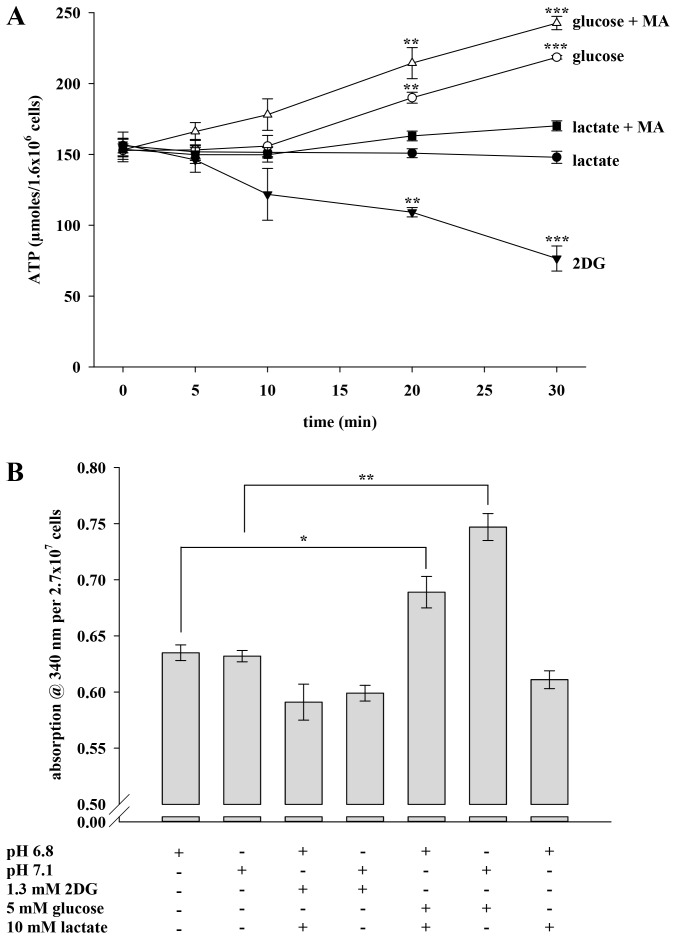
ATP and NDH/NADPH production is dependent on the substrate and the pHi.
A, Sperm prepared as described in the Materials and Methods section were transferred to buffer HS which was supplemented with 1.3 mM 2DG (filled triangles), 10 mM lactate (filled circles), 10 mM lactate +15 mM MA (filled squares), 5 mM glucose (open circles) or 5 mM glucose +15 mM MA (open triangles). The ATP content was determined at t  = 0, 5, 10, 20 and 30 min. Each line represents mean values±s.e. of 4 independent experiments. Significant changes were analyzed relating to t  = 0 min of the respective plot with **p<0.05 and ***p<0.001. B, At t  = 0, sperm were starved out and directly homogenized in HS buffer with pH 6.8 or pH 7.1. After starvation, sperm were further incubated in buffer containing energy substrates as indicated before being homogenized. Absorption at 340 nm was measured over 200 s. Each bar represents mean values±s.e. of 2 independent experiments. *p<0.1 and ***p<0.001.